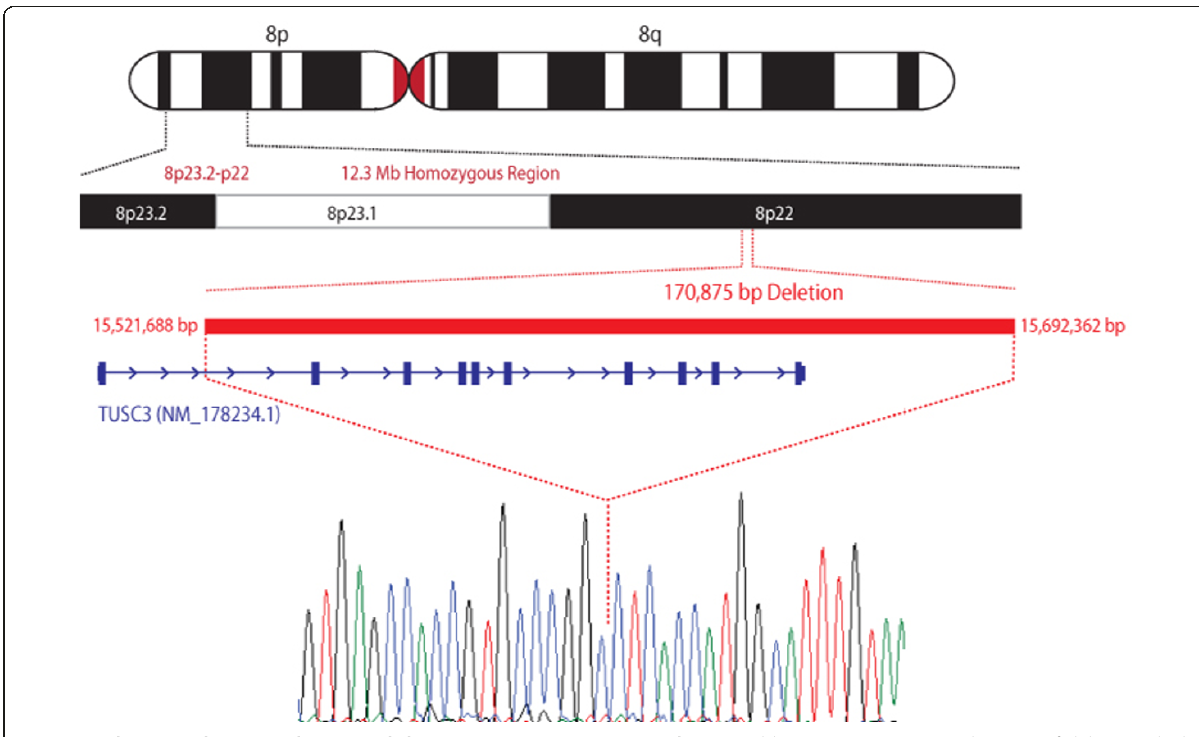
Figure 4 Ideogram depicting the 12.3 Mb homozygous region on 8p23 locus . Red bar is representing total region of deletion which contains TUSC3 gene shown in blue color bar. The dotted line from red bar over the sequence chromatogram indicates the junction